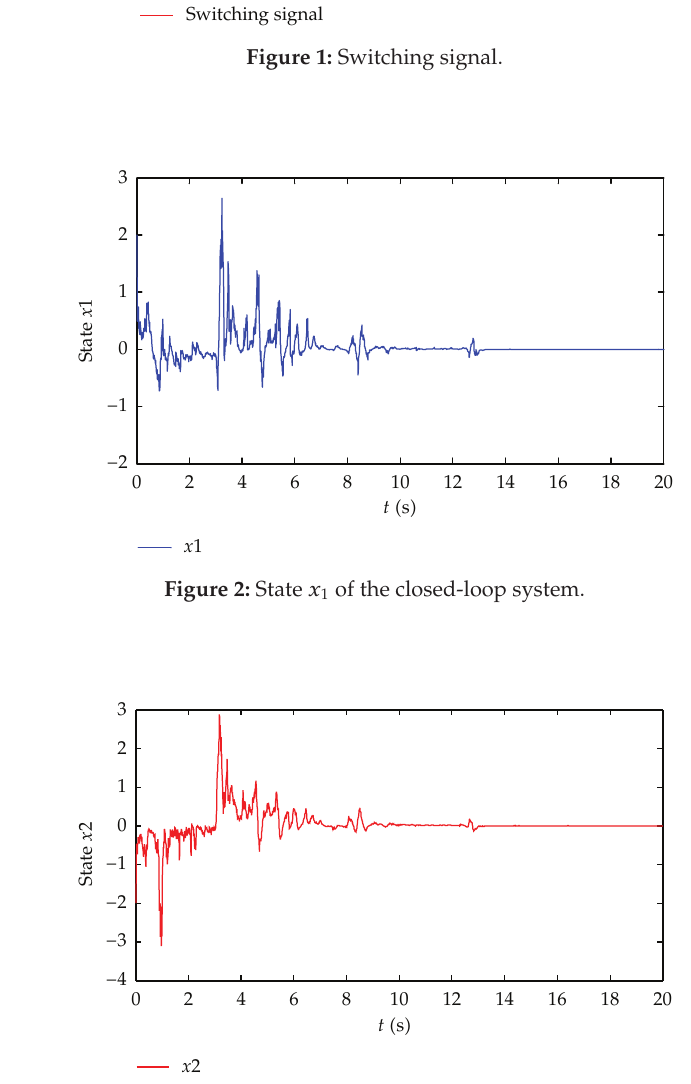
Figure 3: State x 2 of the closed-loop